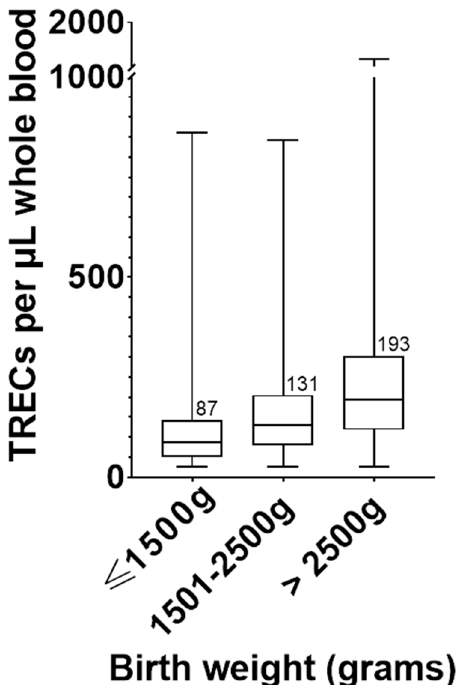
Figure 2. Plot of gestational age versus TRECs. The y -axis of the plot is in the log scale so that the linear regression line can be seen (red line). TREC copy numbers increase 9.6% per additional